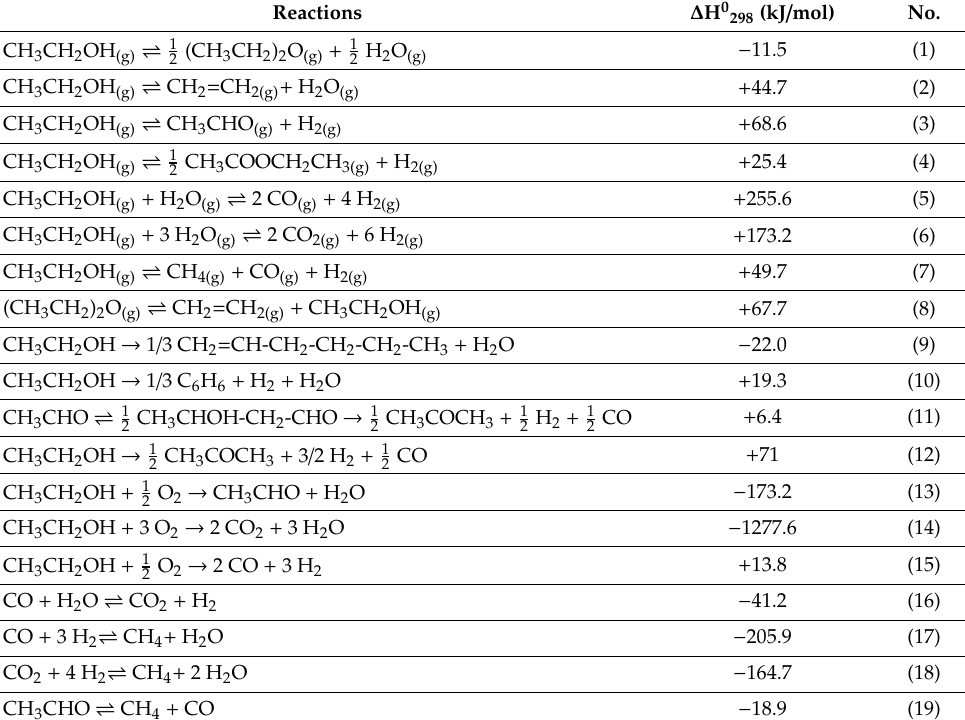
Table 2. Chemical reactions considered and discussed in the text and their reaction enthalpies per mol of